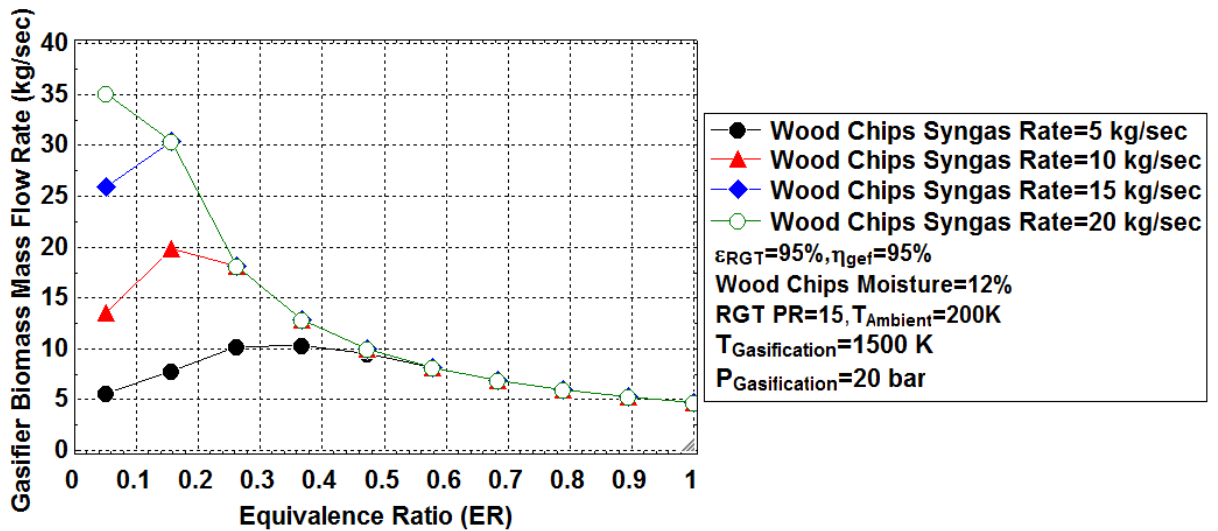
Figure 2. Variation of the equivalence ratio with gasifier’s biomass mass flow rate at different Wood Chip syngas rates.